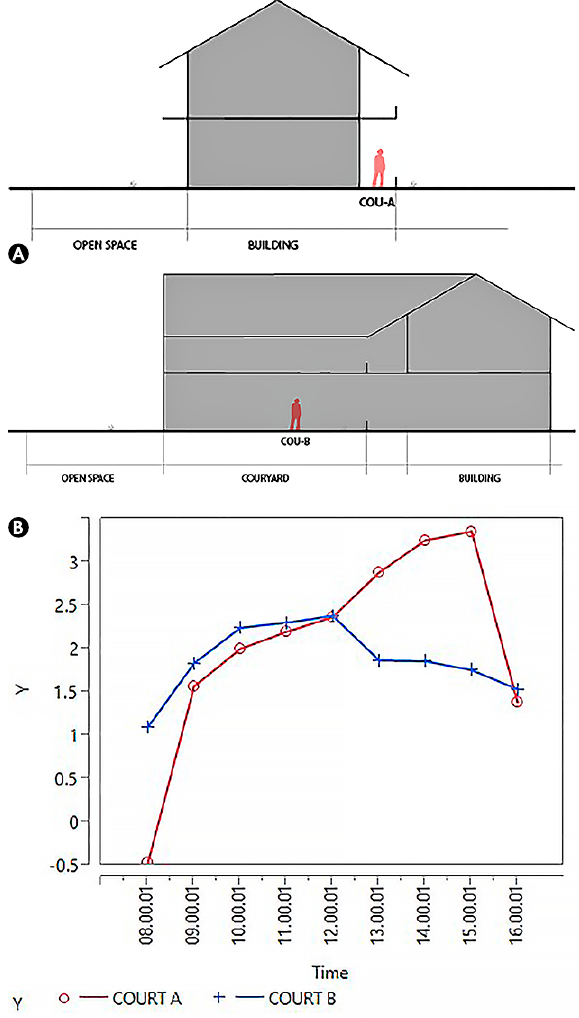
Figure 16. (a) Section of COU-A and COU-B (b) Comparison of PMV at 2 points location in the COU